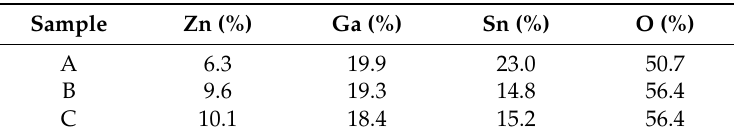
Table 1. Atomic composition of the GaZTO thin film with different oxygen flow ratios, confirmed via X-ray photoelectron spectroscopy